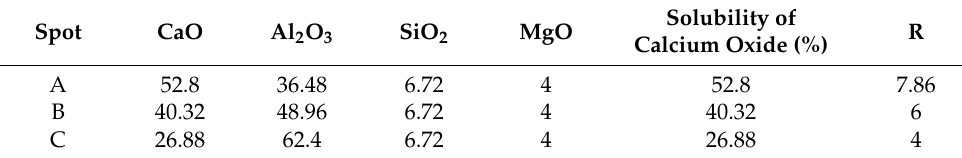
Table 5. Optimized slag composition (wt%) and solubility of calcium